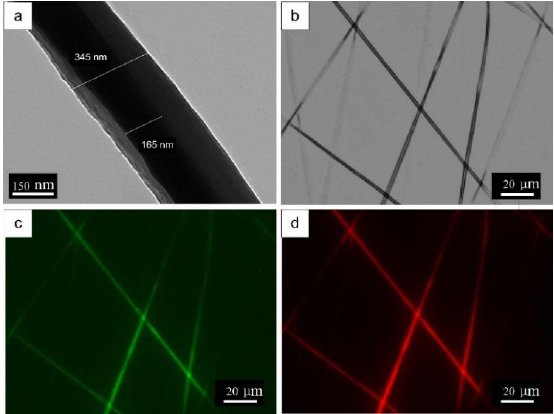
Figure 7. Core-shell structures of the SF-SELP nanofibers: ( a ) transmission electron microscopy (TEM) image and ( b ) phase-contrast image of fibers; ( c ) fluorescent image showing fluorescein isothiocyanate (FTIC)–dextran stained S2E8Y shell phase, and ( d ) fluorescent image showing rhodamine B stained SF cores phase.